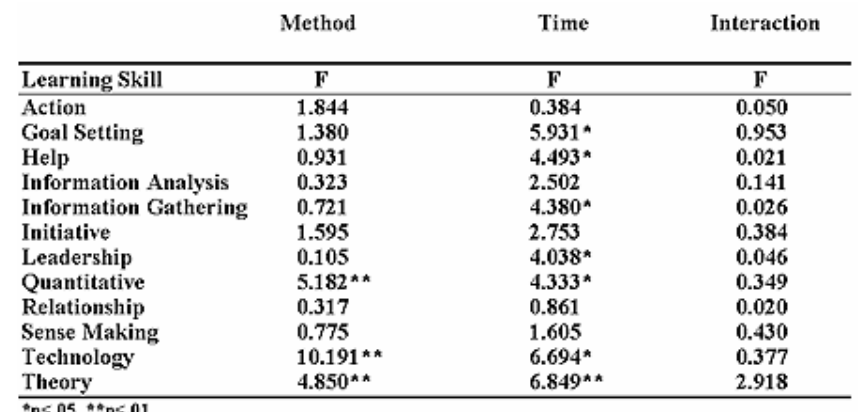
Table 3. Results from Two-Way ANOVA – Learning skill by method and